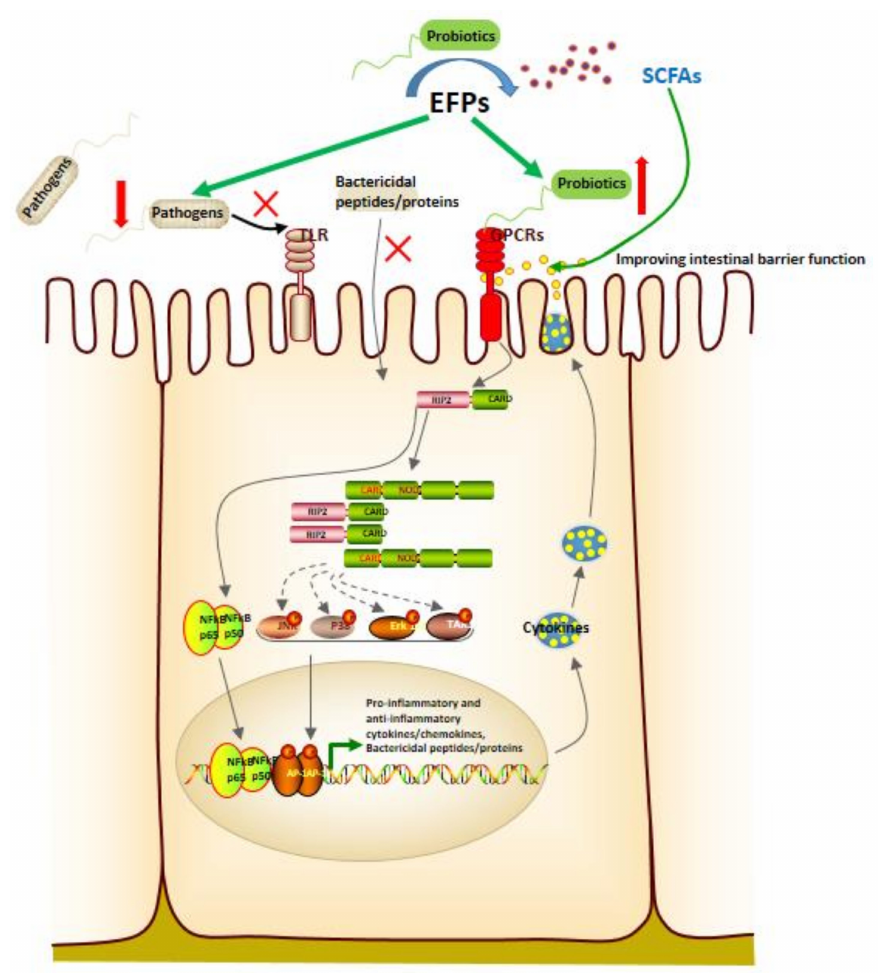
Figure 15. Probiotic mechanism of EFPs in